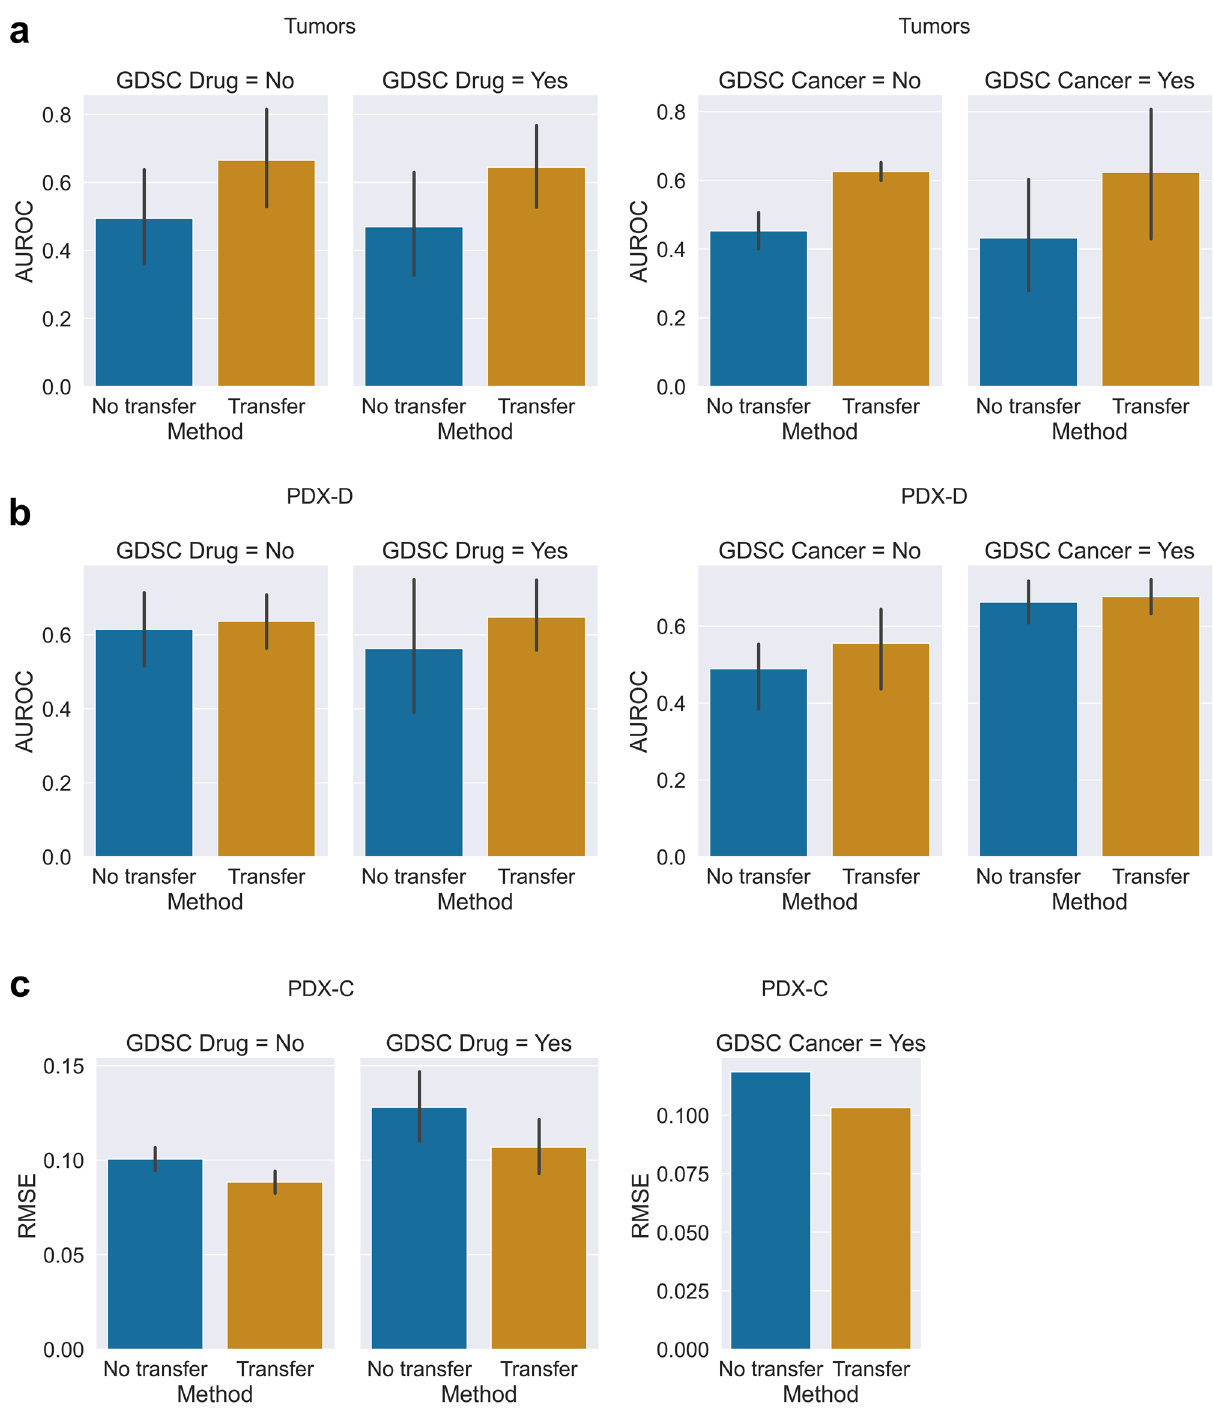
Figure 3. Bar plot of per-drug and per-cancer performance averaged across drugs (left panel) and cancers (right panel). Comparison is between predictions made on drugs or cancer types that exist in the cell line repository of GDSC (panels titles “GDSC Drug = Yes” or “GDC cancer = Yes”) and drugs/cell lines that appear only in the tumor or PDX samples (panels titles “GDSC Drug = No” or “GDC cancer = No”). Bar lengths are mean values, and error bars represent one standard deviation. ( a ) Area Under the Receiver Operating Curve (AUROC) for the tumor data averaged across 15 drugs (n = 8, 7 for GDSC drugs and non-GDSC drugs), and 10 cancers (n = 8, 2 for GDSC cancer types and non-GDSC cancer types). ( b ) The average of AUROC over the PDX-D predictions consisting of 12 drugs and 5 cancer types (n = 3, 9 for GDSC drugs and non-GDSC drugs; n = 2, 3 for GDSC cancer types and non-GDSC cancer types). ( c ) The average Root Mean Squared Error (RMSE) for 340 drugs and 1 cancer type in the PDX-C predictions (n = 30, 310 for GDSC drugs and non-GDSC drugs, n = 1 for GDSC cancer